Question: In one sentence, what is this figure communicating?
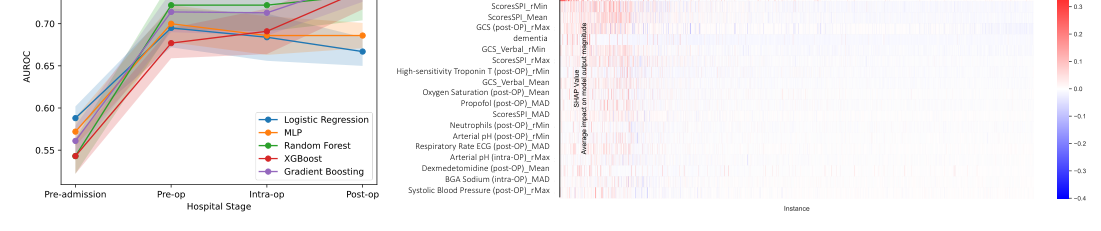
Answer: Predictive model performance for different hospital stages and personalized explanation with cohort with post+-op features.